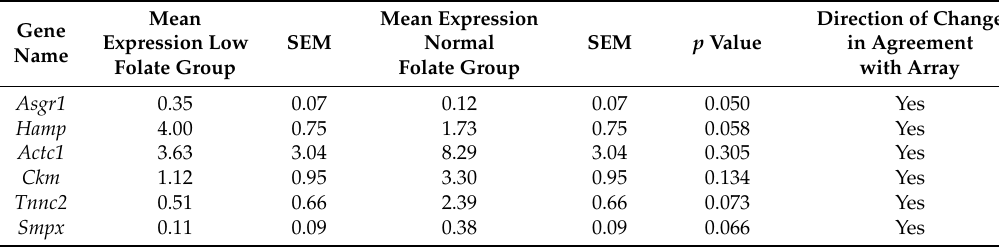
Table 8. RT-qPCR expression analysis of selected genes which were differentially expressed in fetal liver in response to maternal folate depletion 1,2 when assayed by microarray.